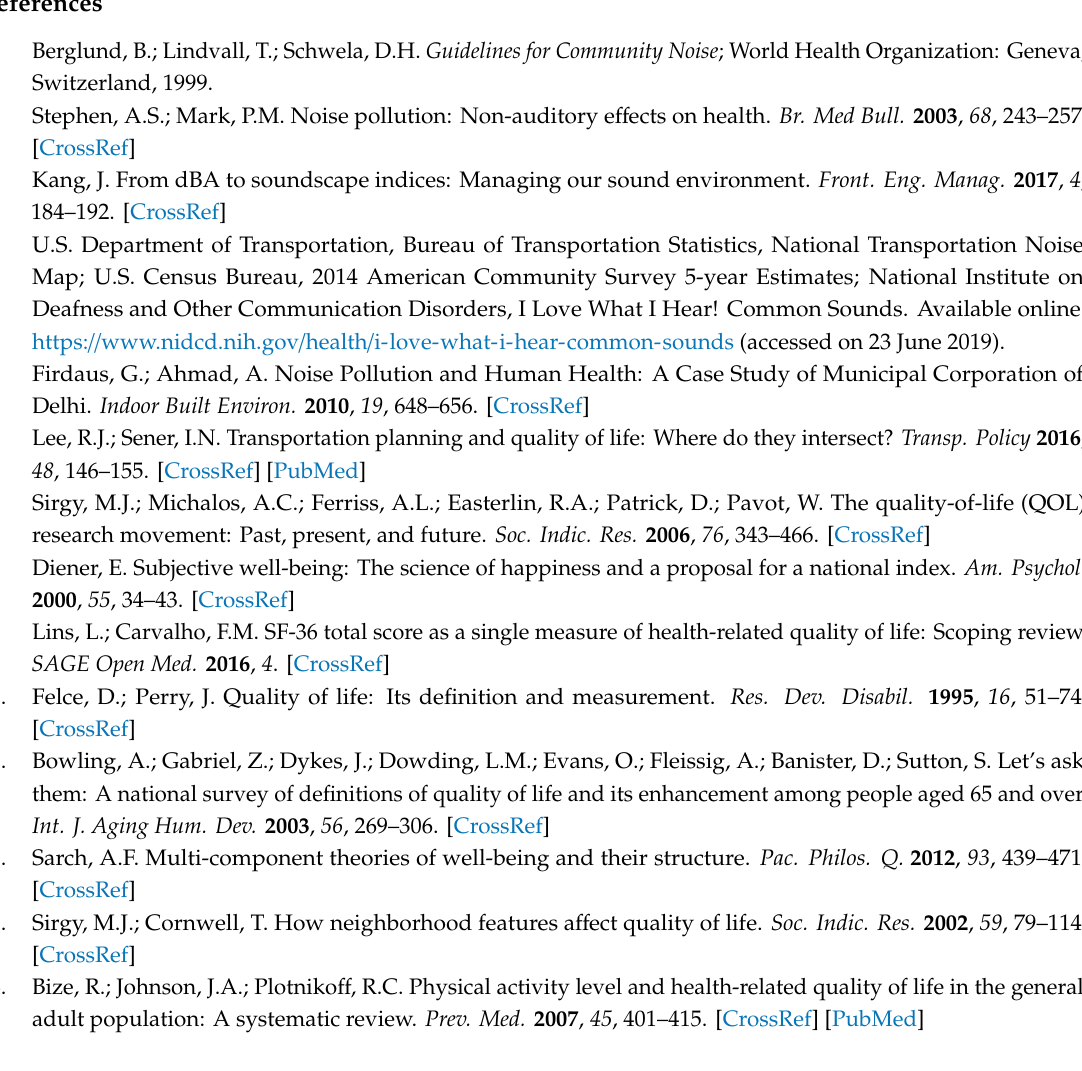
Table S1: Site measurements and